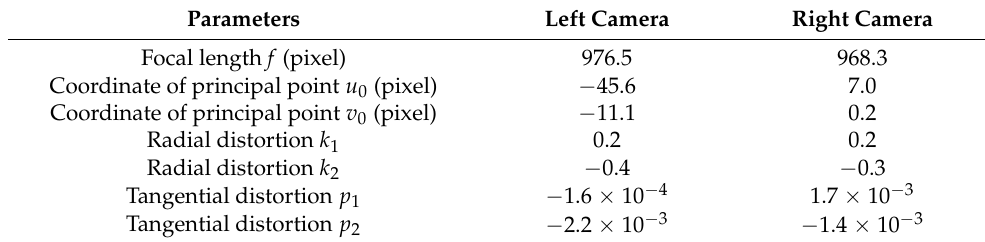
Table 1. Laboratory calibration results of the navigation cameras.